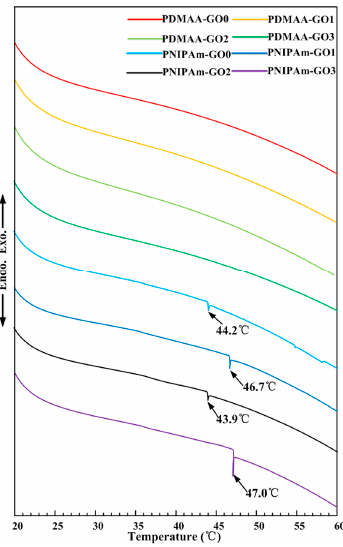
Figure 4. Differential Scanning Calorimetry (DSC) profiles of PDMAA and PNIPAm hydrogels with various GO contents.